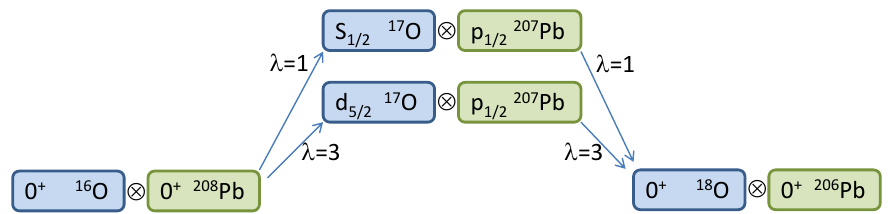
Figure 2. Scheme of channels for the example reaction 16 O( 208 Pb, 206 Pb) 18 O. Only two states of oxygen are used for the sake of simplicity. More accurate schemes must contain all relevant single-particle states in both target and projectile and, for each combination, all possible values of λ .